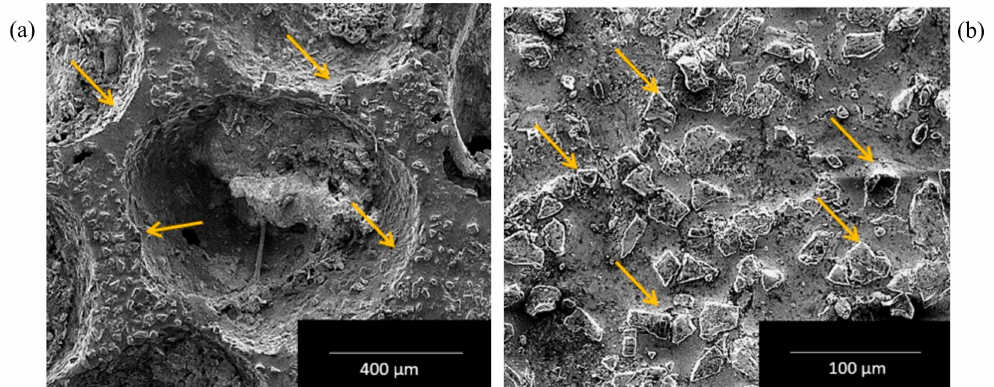
Figure 4. ( a ) SEM micrograph showing pores and SiC particles in the cell walls; ( b ) micrograph showing the distribution of SiC particles in the cell